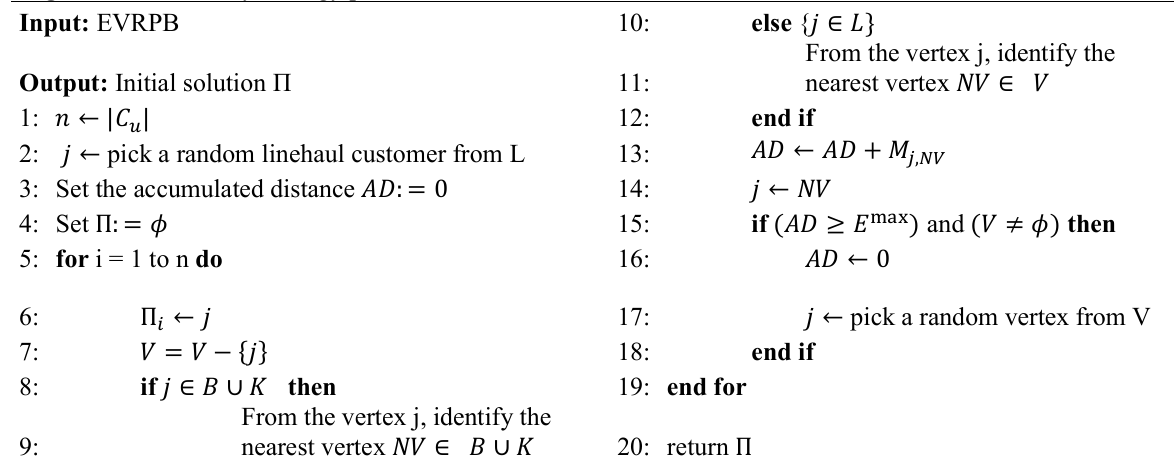
Algorithm 1. Greeddy strategy pseudo